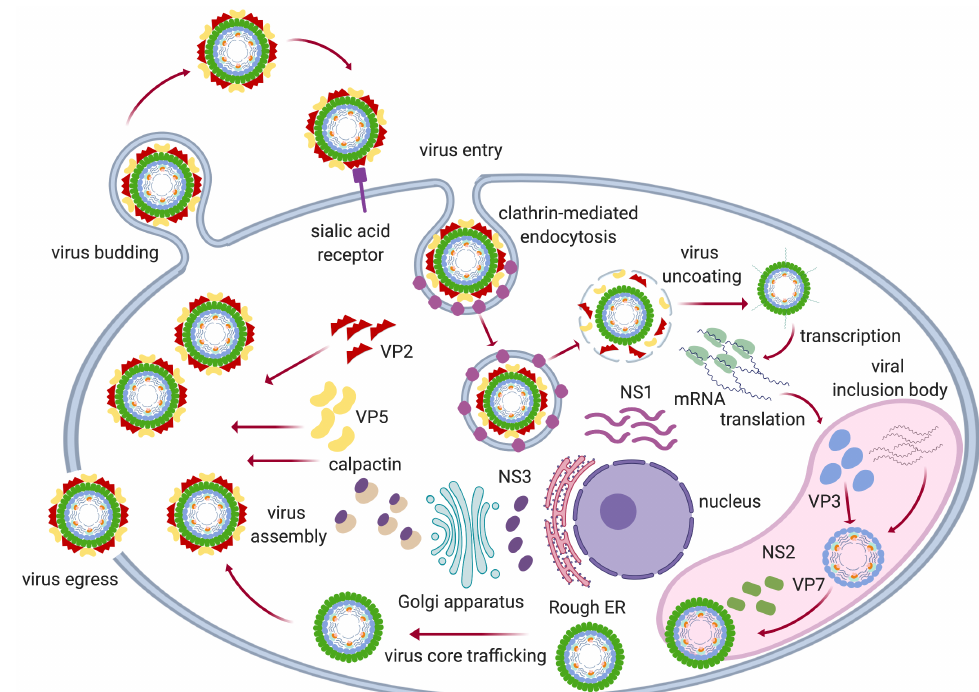
Figure 3. Diagrammatic representation of the replication cycle of BTV / AHSV. The virus enters the cell by the attachment of VP2 to sialic acid receptors and either clathrin-mediated endocytosis or macropinocytosis. The acidic pH in the endosome causes the loss of VP2 and mediates VP5 membrane permeabilization, which results in uncoating of the virion and release of the transcriptionally active core particle into the host cell cytoplasm. Transcription and translation of viral proteins occurs, utilizing the host cell machinery and the VIBs act as sites of assembly for the progeny virions. Assembled core particles are then tra ffi cked from the VIB on exocytotic vesicles by NS3 interaction with calpactin. The outer capsid proteins VP5 and VP2 are acquired during this process to produce mature virions. Particles are released from the cell via budding mediated by NS3 or via host cell lysis. Image adapted from [53] and created with Biorender.com